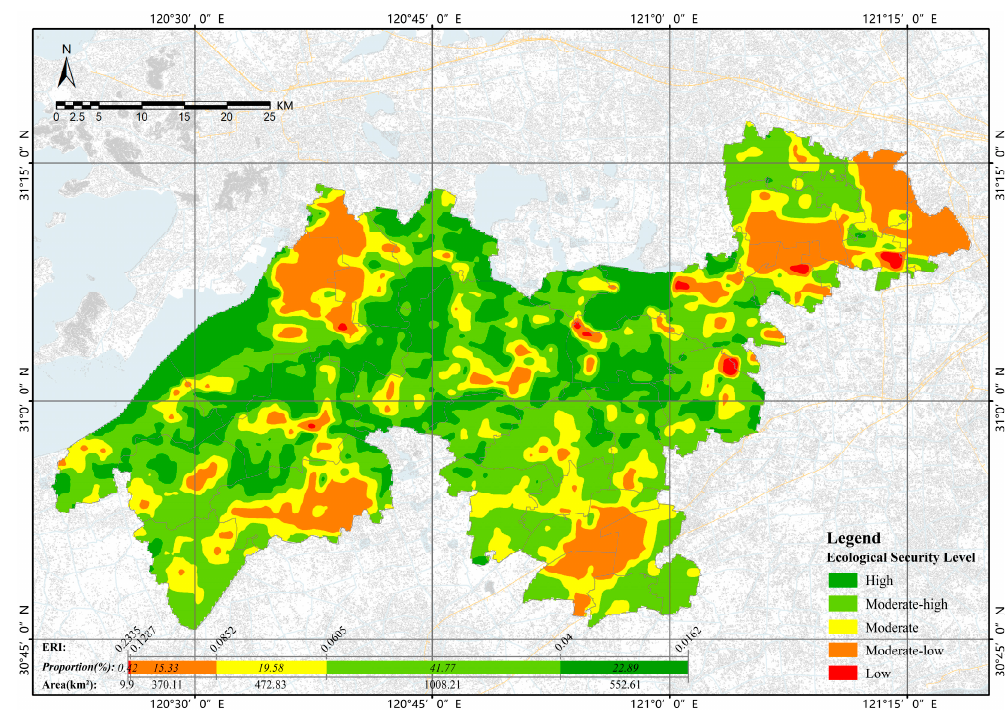
Figure 8. Ecological security analysis of the demonstration area.